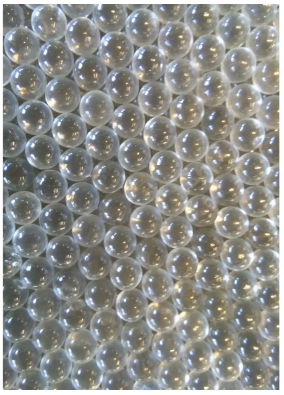
Figure 1. Example of the loose bed glass spherical particles with 5 mm